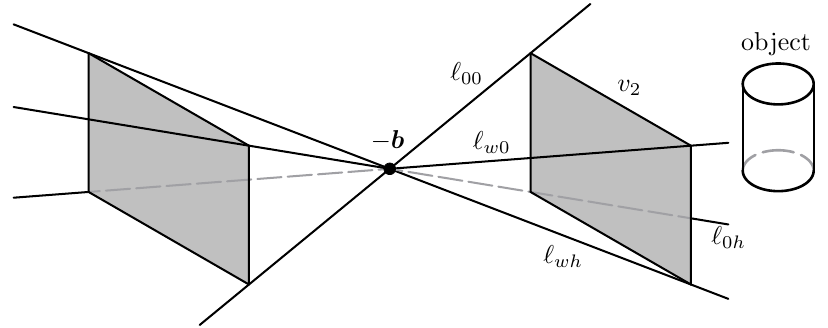
Figure 2. Converging lines and rectangular area v 2 .